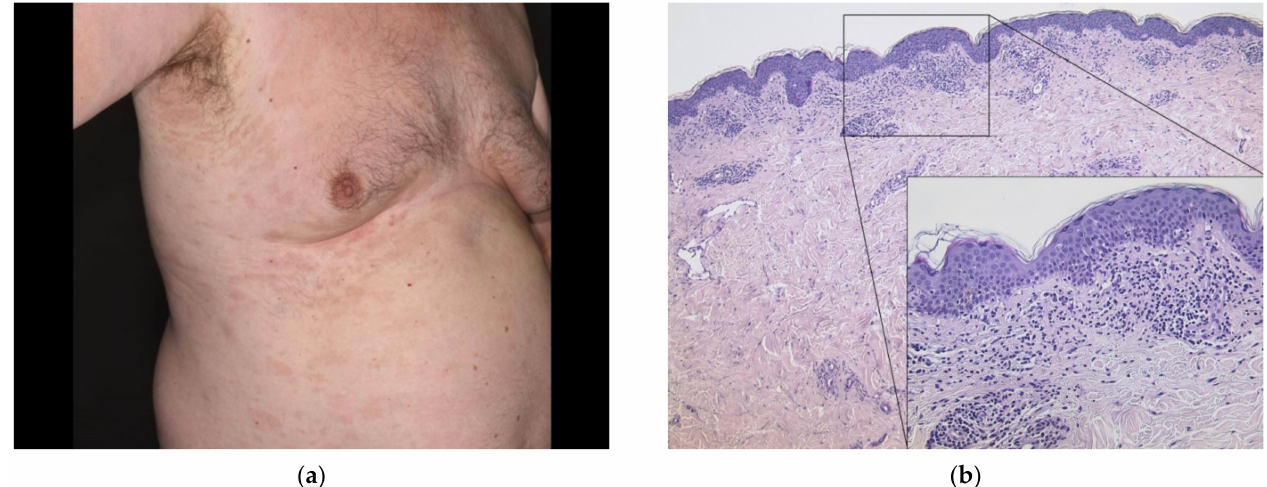
Figure 6. ( a ) Clinical findings three weeks after the first dose of AZD1222 featuring a non-scaling exanthema with distribution following the Langer lines. ( b ) Histological findings of a skin biopsy taken from the trunk of the patient showing a superficial perivascular lymphocytic infiltrate with interface dermatitis and erythrocyte extravasation (HE, original magnification 50 × ; detail original magnification 200 ×